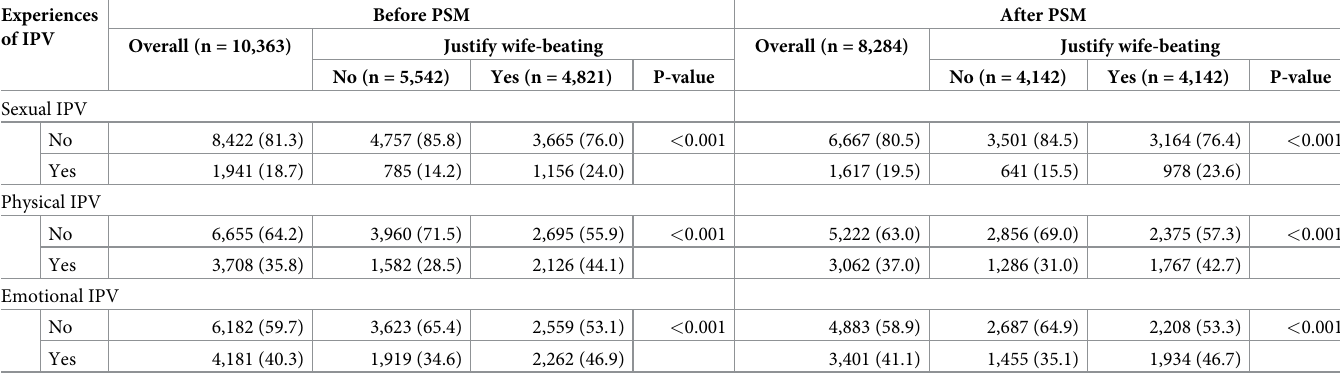
Table 3. Number of respondents (%) reporting experiences of IPV before and after matching PSM.